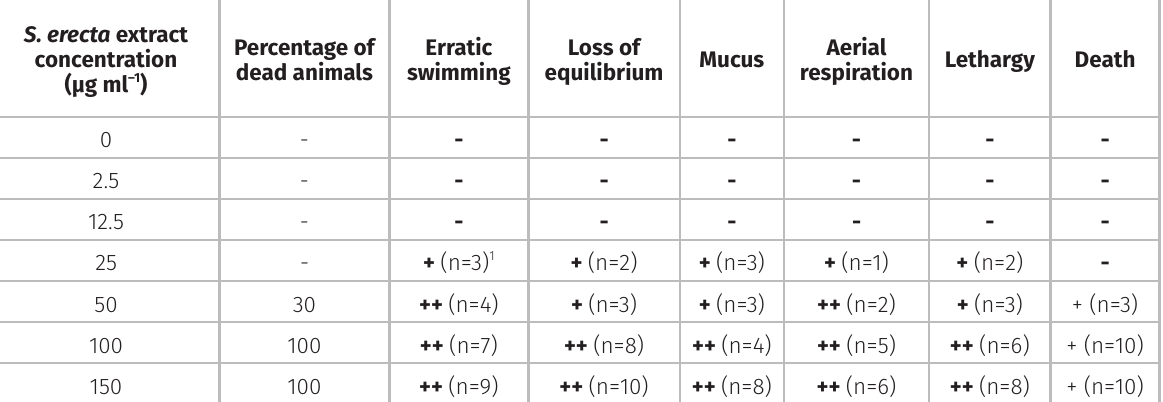
Table I. Mortality and behavioral alterations observed in Piaractus mesopotamicus (n=10) exposed to Serjania erecta aqueous extract for 4